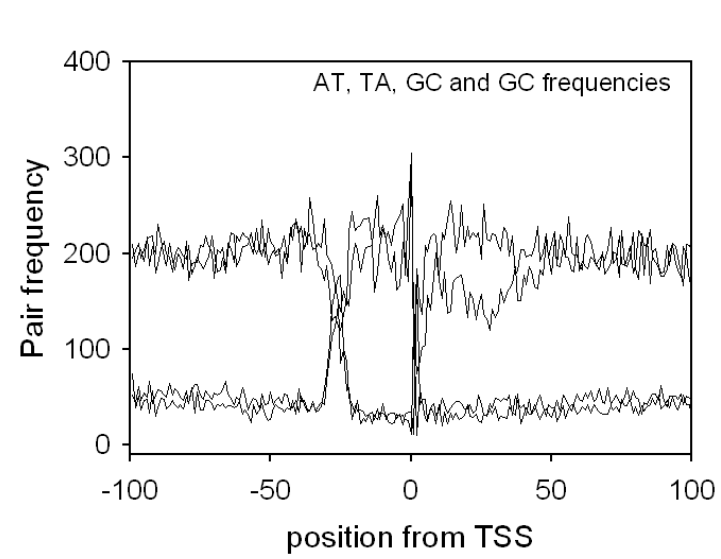
Figure 1: The four dinucleotides AT, TA, GC and CG frequencies have been plotted as a function of their position from the transcription start site. The 12 other dinucleotides have been omitted from this graph in order to improve the visual clarity. The lower graphs refer to the AT / TA and the upper graphs refer to GC / CG. We claim that the distributions in the region TSS-50 to TSS + 50 is anomalous. The very sharp spike at the TSS is caused by the start